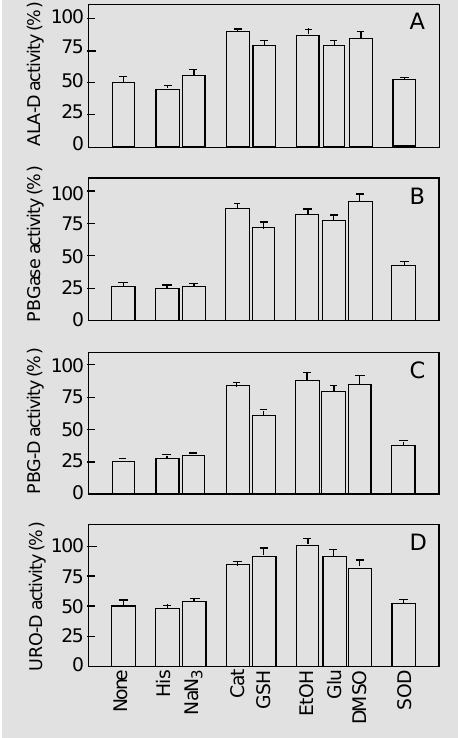
Figure 4 - Effect of the presence of scavengers on the URO I-in- duced enzyme inactivation. ALA- D, PBGase, PBG-D and URO-D were preincubated for 30 min at 30 o C in the presence of histi- dine (15 mM), sodium azide (15 mM), catalase (200 nM), reduced glutathione (15 mM), ethanol (15 mM), glucose (11 mM), dimethyl sulfoxide (1.2 mM) or superox- ide dismutase (10 mM), and then exposed to 10 mM (A, B, C) or 100 mM (D) URO I for 2 h at 37 o C, under UV